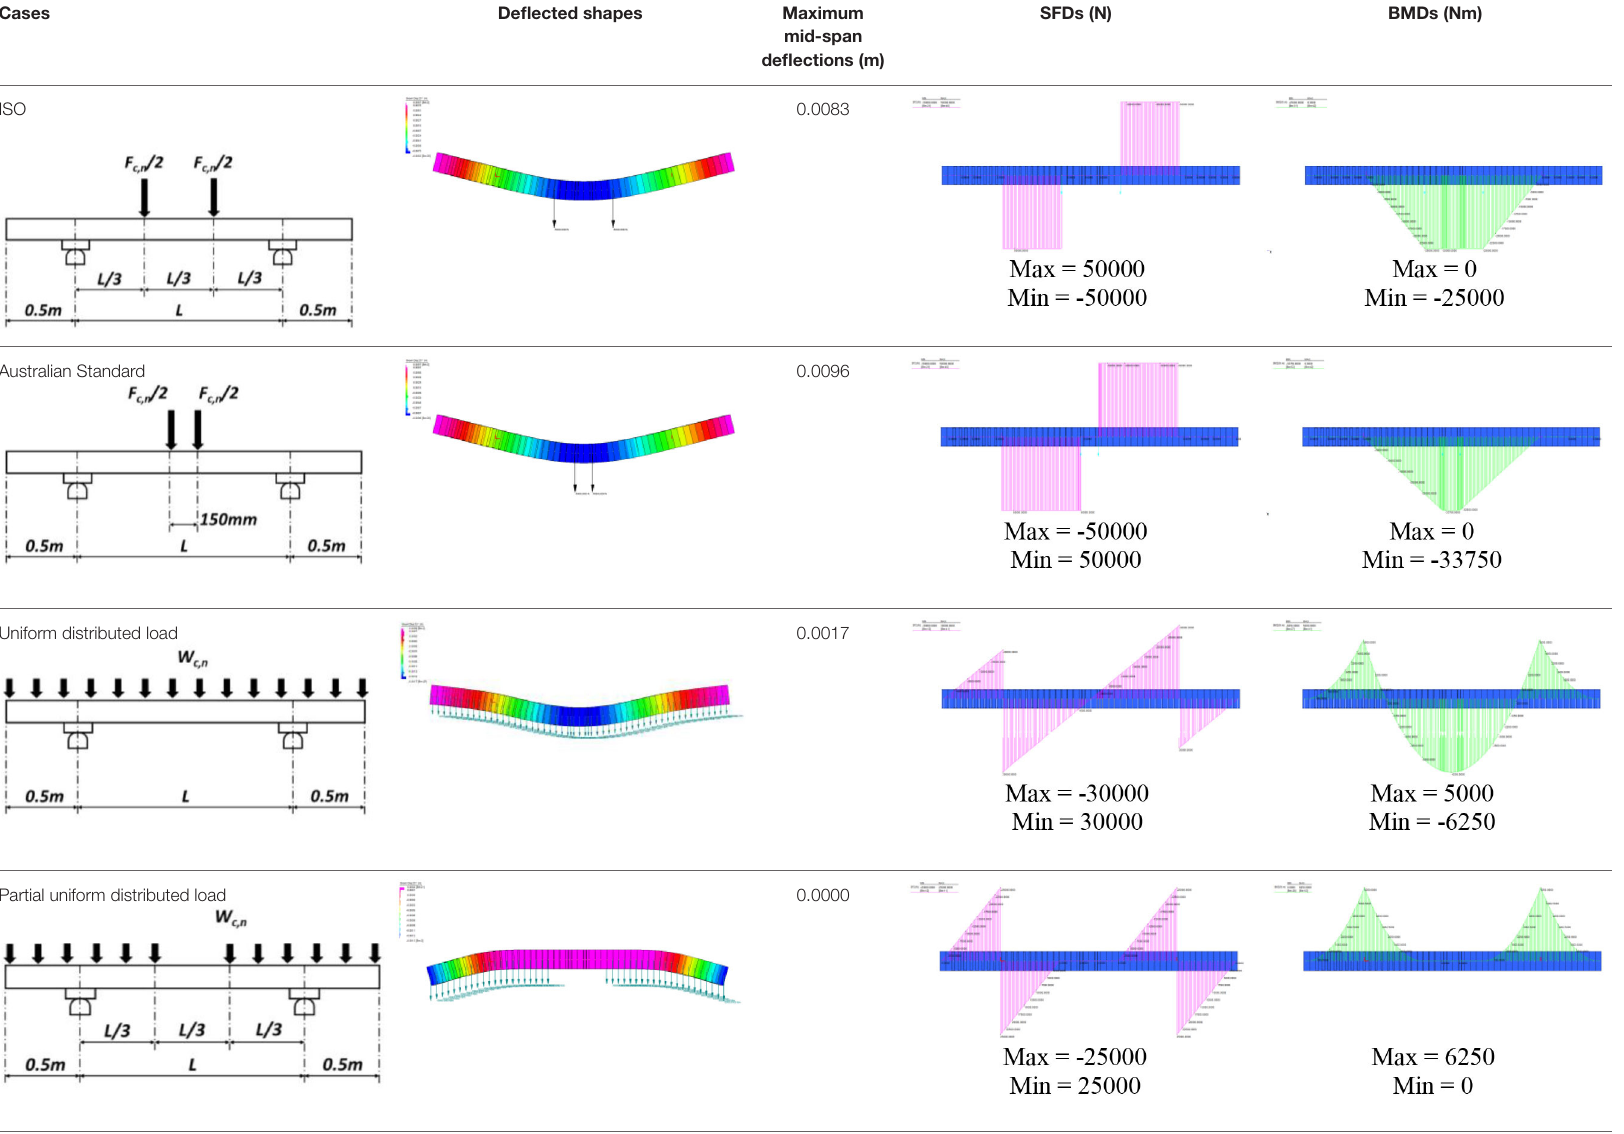
TABLE 1 | Comparisons of test methods and resultant responses (deflection, shear force, and bending moment).